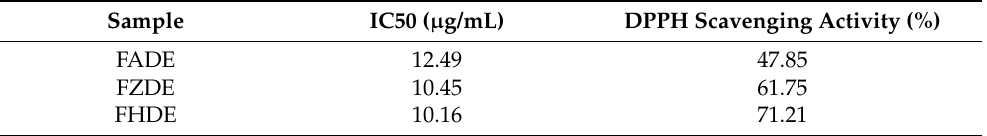
Table 6. Antioxidant activity of FADE, FHDE, and FZDE extracts. Sample IC50 ( µ g/mL)